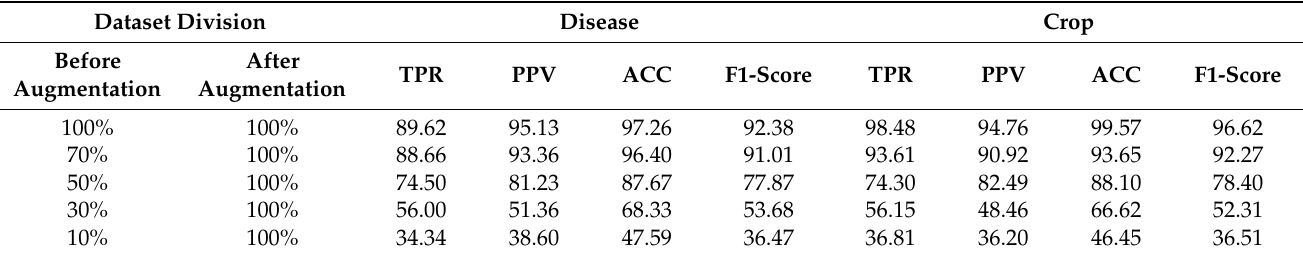
Table 25. Comparison of accuracies achieved by the proposed PI-CNN in the original and PI-GAN- augmented datasets. The accuracies were achieved in the PlantVillage dataset (unit: %).